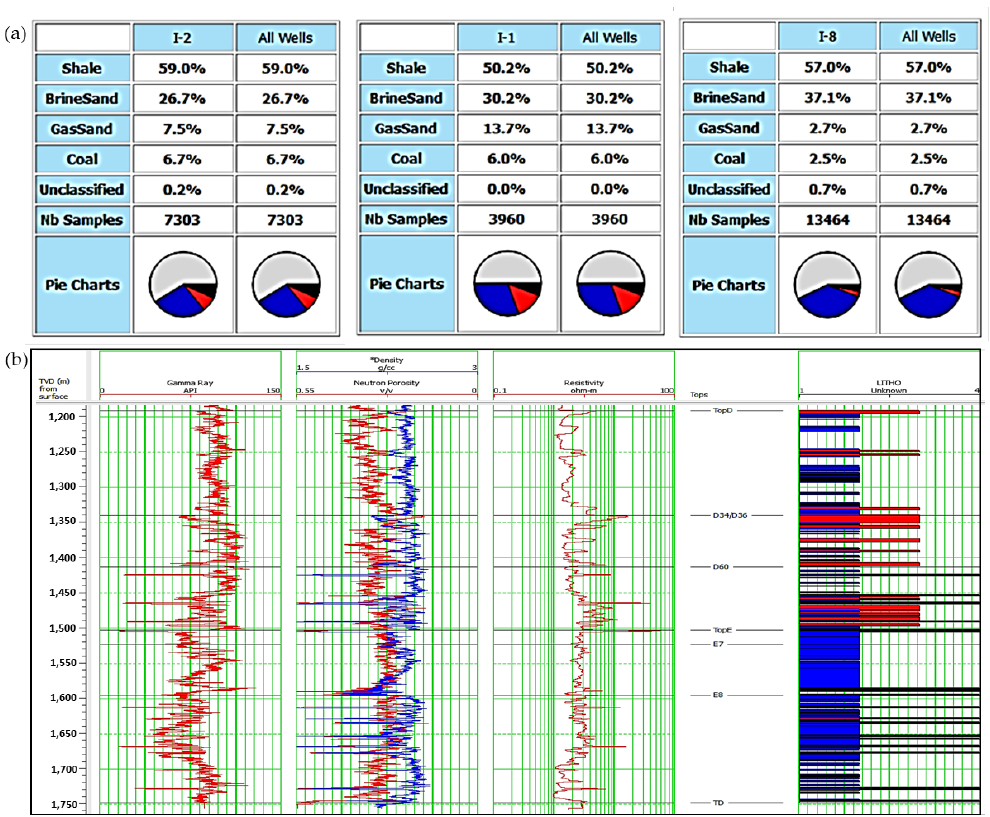
Figure 9. ( a ) Facies percentage in I-1, 1-2, and I-8 logs, ( b ) facies discrimination compared to any logs such as gamma-ray, density, neutron, and resistivity.